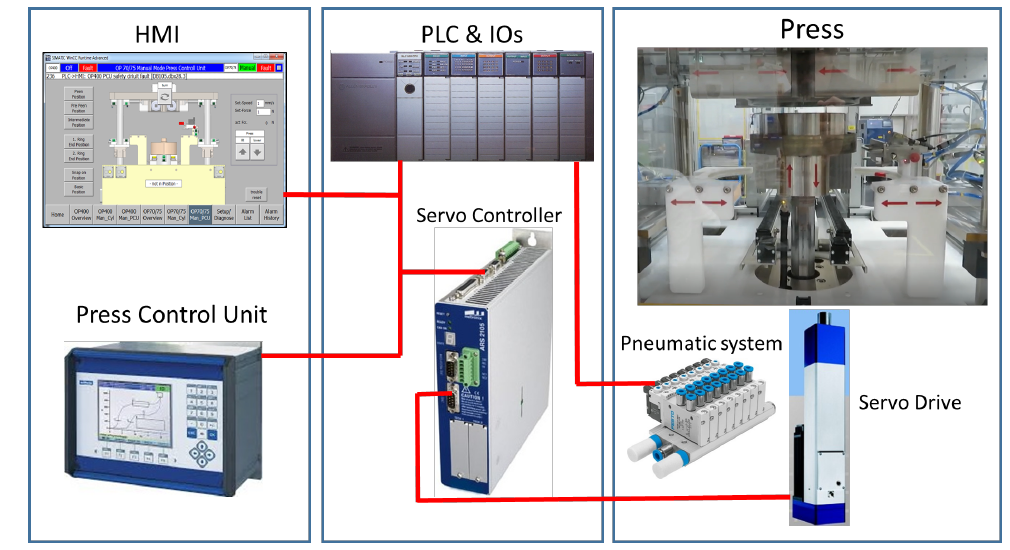
Figure 7. Vertical assembly physical machine